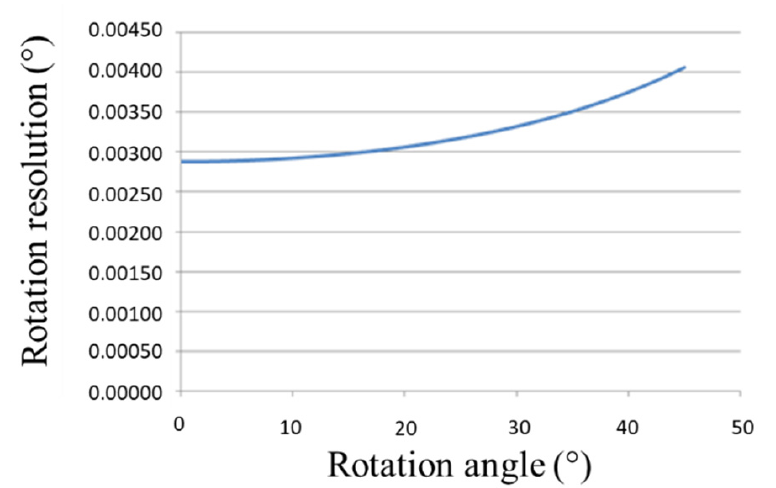
Figure 5. Platform linear travel vs. tilt-drive angle.